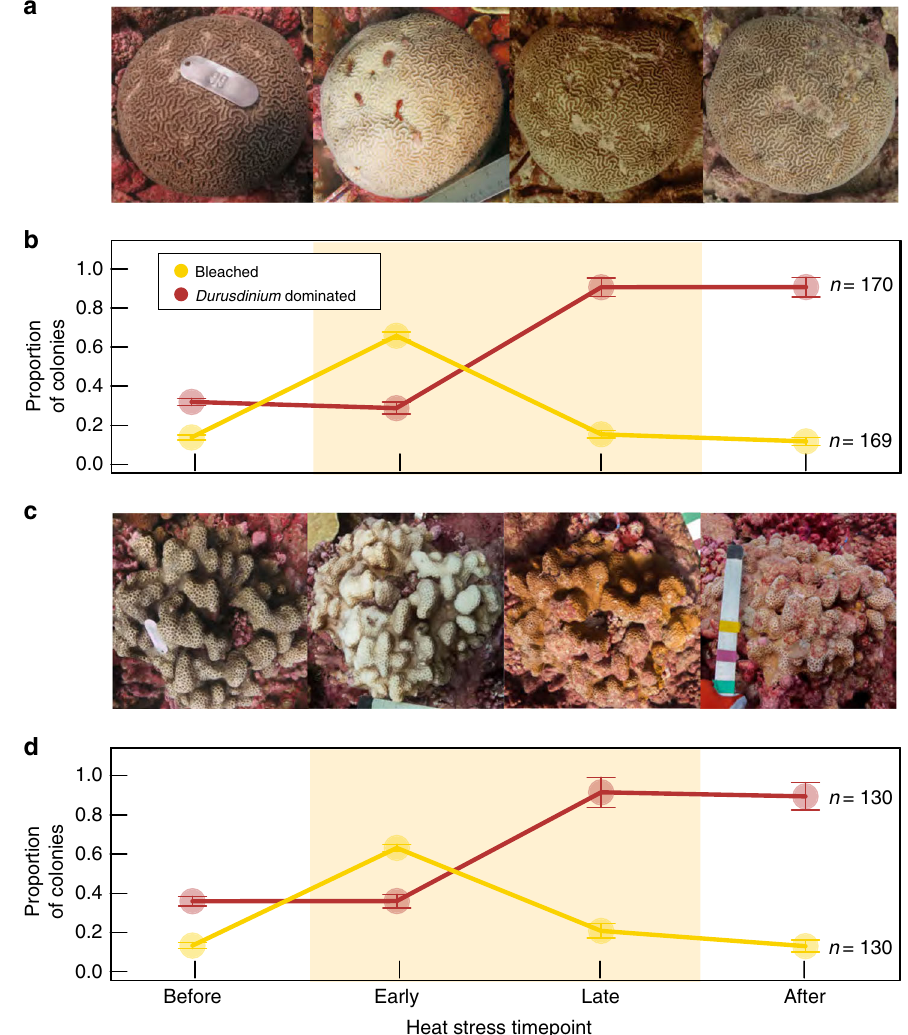
Fig. 3 Progression (healthy – bleached – recovered) of coral colonies during the 2015 – 2016 El Niño. a , c Examples of single tracked coral colonies of a P. ryukyuensis and c Favites pentagona that bleached and recovered during the heatwave. b , d Proportion of coral colonies of b P. ryukyuensis and d F. pentagona that were dominated by heat-tolerant symbionts (>50% Durusdinium sequence reads) and proportion that were bleached (mean ± 95% CI), at time points spanning from before to after the El Niño-induced heat stress: before = the most recent time point before the heatwave (i – iii), early (iv), late (vi), and the most recent time point after the event (vii, viii). Expedition time points correspond to those in Figs. 2 and 4. Sample sizes refer to total number of samples (bleaching status or symbiont identities) taken from coral colonies across all time points. Shaded pale yellow areas in b and d correspond to >4 degree heating weeks from Fig.